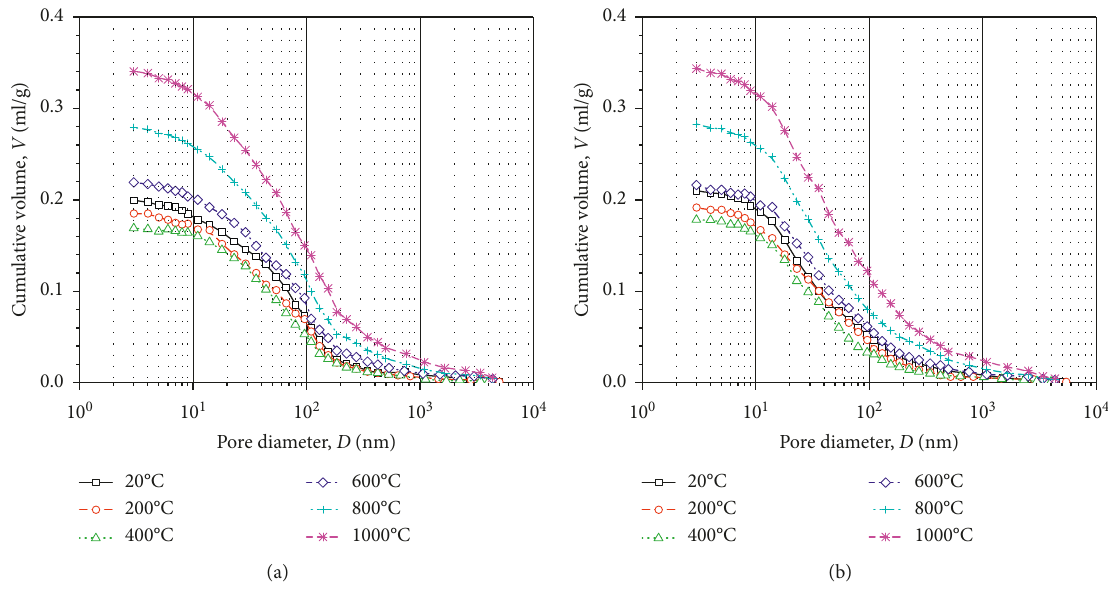
Figure 6: Pore size distribution of (a) C0 and (b) C10F30 before and after exposure to various temperatures.